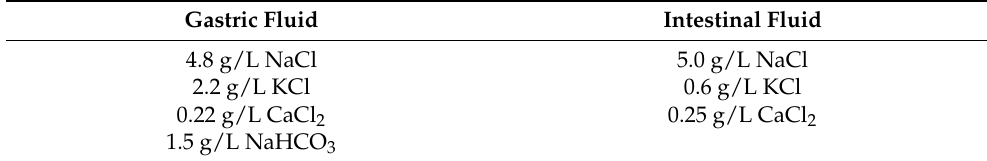
Table 1. Salt concentrations of simulated gastrointestinal